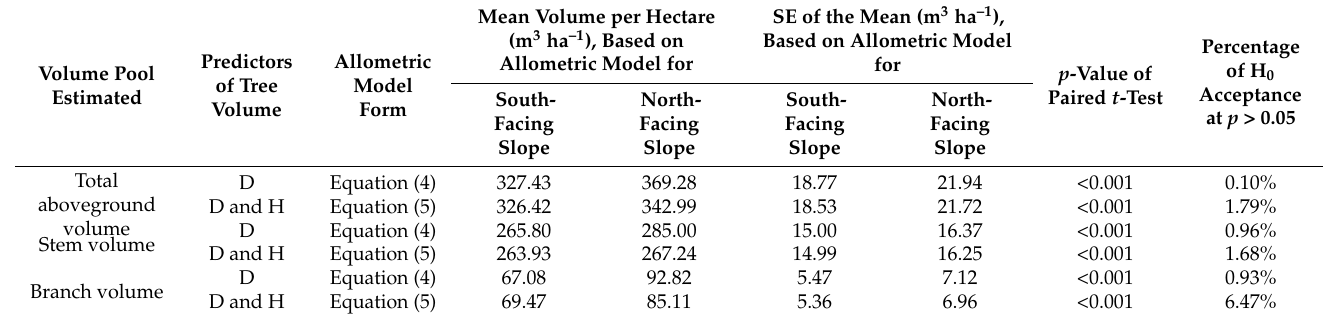
Table 4. The mean volume per hectare (Equation (6)) and standard error of the mean (Equation (7)) based on south- and north-facing slope allometric models, the p -values of the paired t -test, and the rates of H 0 acceptance within the paired t -test, by volume pool estimated and allometric model